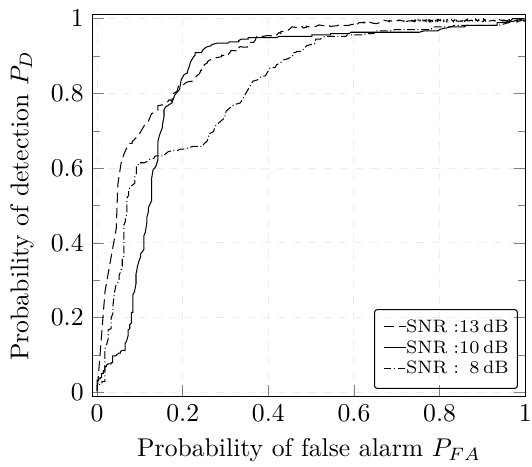
Figure 12. ROC curve of the CUSUM